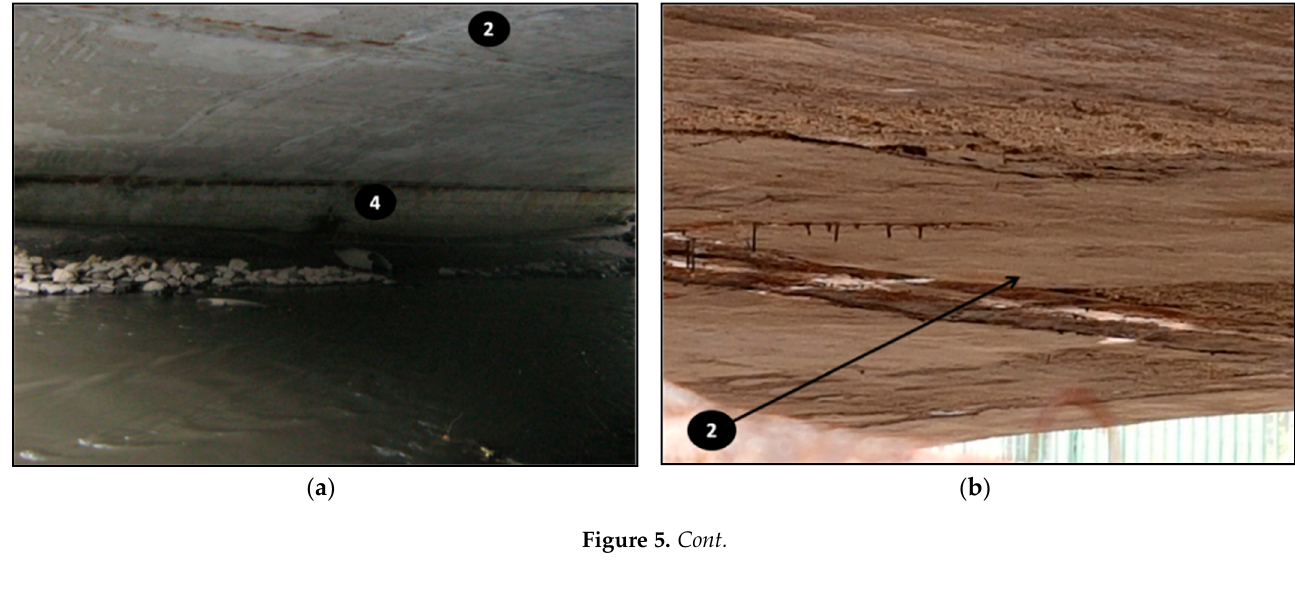
Figure 4. Location of samples of concrete and water shown before demolition of the bridge.